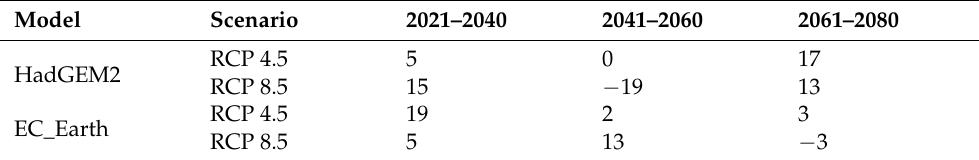
Table 3. Summary of percentage change in streamflow during 2021–2040, 2041–2060 and 2061–2080 for climate scenarios: RCP 4.5 and RCP 8.5 of GCM models: HadGEM2 and